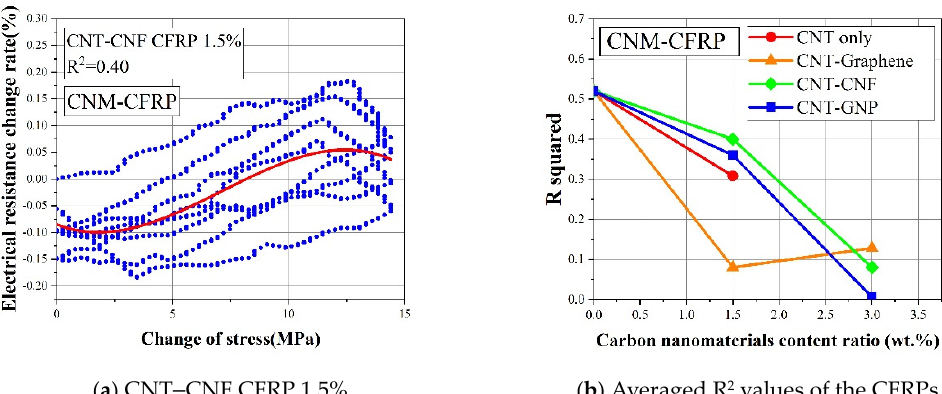
Figure 13. ( a ) The cubic polynomial regression fitted from the applied loadings and the electrical resistance change rates and ( b ) averaged R 2 values of the CNM-incorporated CFRP composites.